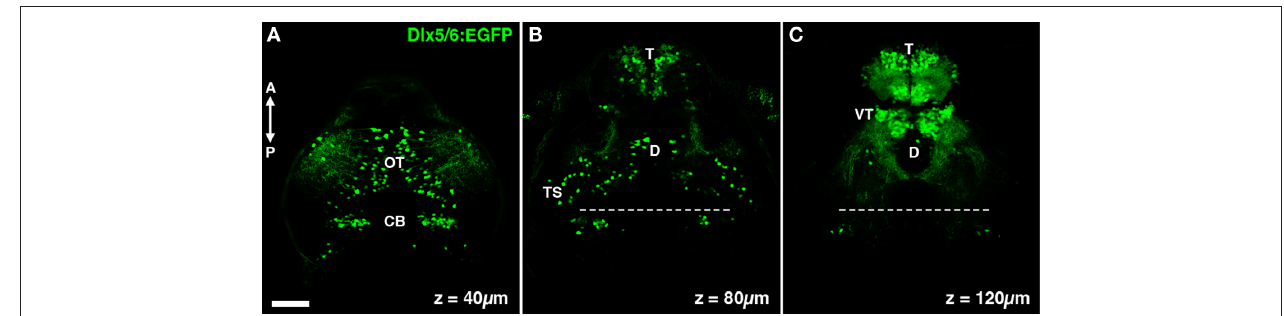
in addition to sparse labeling throughout the diencephalon (D) and mesencephalic structures such as the torus semicircularis (TS). (C) At a depth of 120 μm labeling is largely restricted to the telencephalon and the ventral thalamus (VT). Dashed line indicates midbrain–hindbrain boundary. Scale bar, 50 μm.